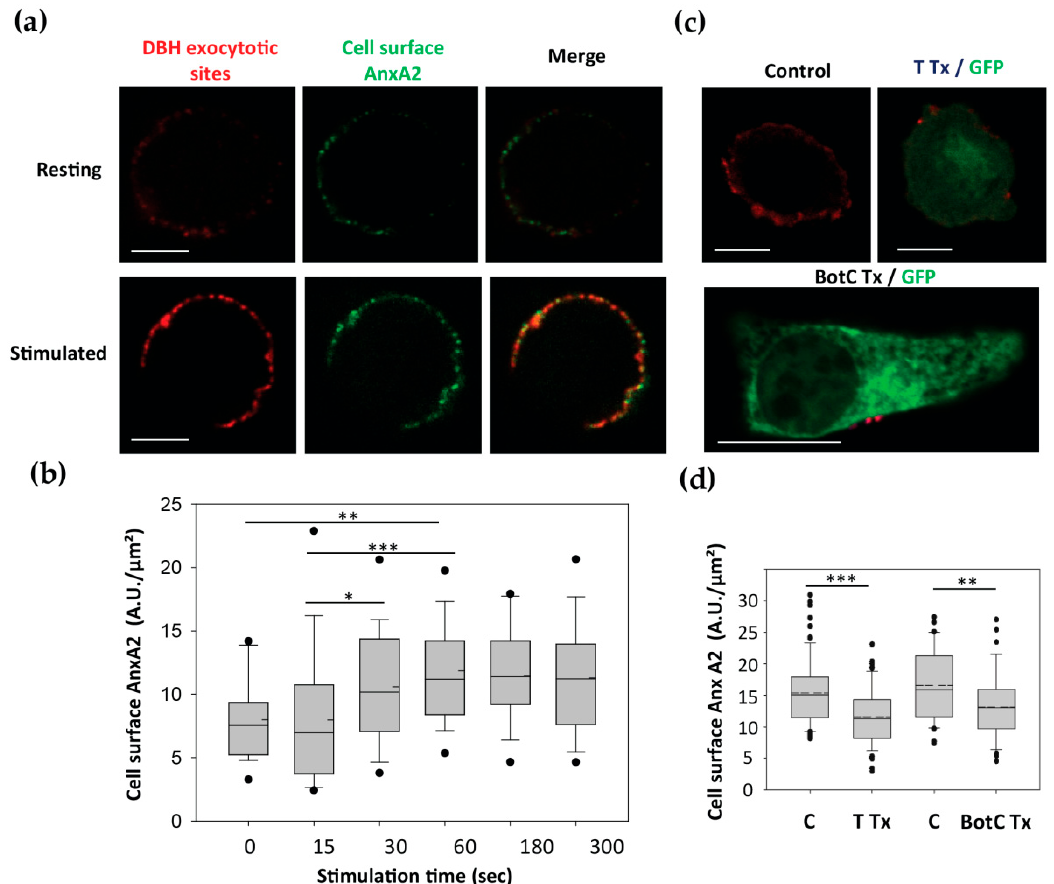
Figure 3. AnxA2 egress was correlated with exocytosis. ( a ) Dual labeling of cell surface AnxA2 and exocytotic sites. Cells were stimulated with nicotine 20 µM in the presence of anti-DBH and anti-AnxA2 antibodies. Cells were then fixed and incubated with secondary antibodies coupled to Alexa Fluor ® 561 and Alexa Fluor ® 488, respectively. Confocal images were recorded in the same optical section and with the same parameters of lasers and photomultipliers. Scale bar: 10 µM. ( b ) Time course of AnxA2 egress after cell stimulation. Chromaffin cells were stimulated with 20 µM nicotine during different times in the presence of AnxA2 antibodies. The cell surface AnxA2 labeling is expressed in arbitrary units. Statistical significance for medians was determined using a Mann-Whitney test. Dotted lines indicate the mean and asterisks statistical significance (*** = p < 0.001, ** = p < 0.01, * = p < 0.05). Two experiments were done on independent cell cultures and pooled. Number of cells analyzed were 19 (0 s), 25 (15 s), 29 (30 s), 23 (60 s), 21 (180 s). ( c ) Effect of tetanus and botulinum C toxins on the AnxA2 egress in chromaffin cells. Electroporated cells expressing TTx/GFP, BotC Tx/GFP or no toxin (Control, C) were stimulated with high K + solution in the presence of anti-AnxA2 antibodies, fixed and then incubated with secondary antibodies coupled to Alexa Fluor ® 561. Confocal images were recorded in the same optical section. Scale bar: 10 µM. ( d ) Semi-quantitative analysis of cell surface AnxA2 labeling in stimulated cells is expressed in arbitrary units (Control n = 79 cells, TTx/GFP n = 69 cells, Control n = 39 cells, BotC Tx/GFP n = 39 cells). Statistical significance for medians was determined using a Mann-Whitney test. Dotted lines indicate the mean and asterisks statistical significance (*** = p < 0.001, ** = p < 0.01). Three experiments were done on independent cell cultures and pooled.